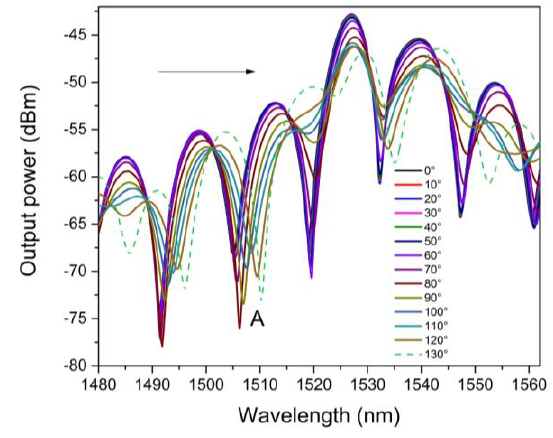
Figure 7 The Wavelength shifting as torsion function.